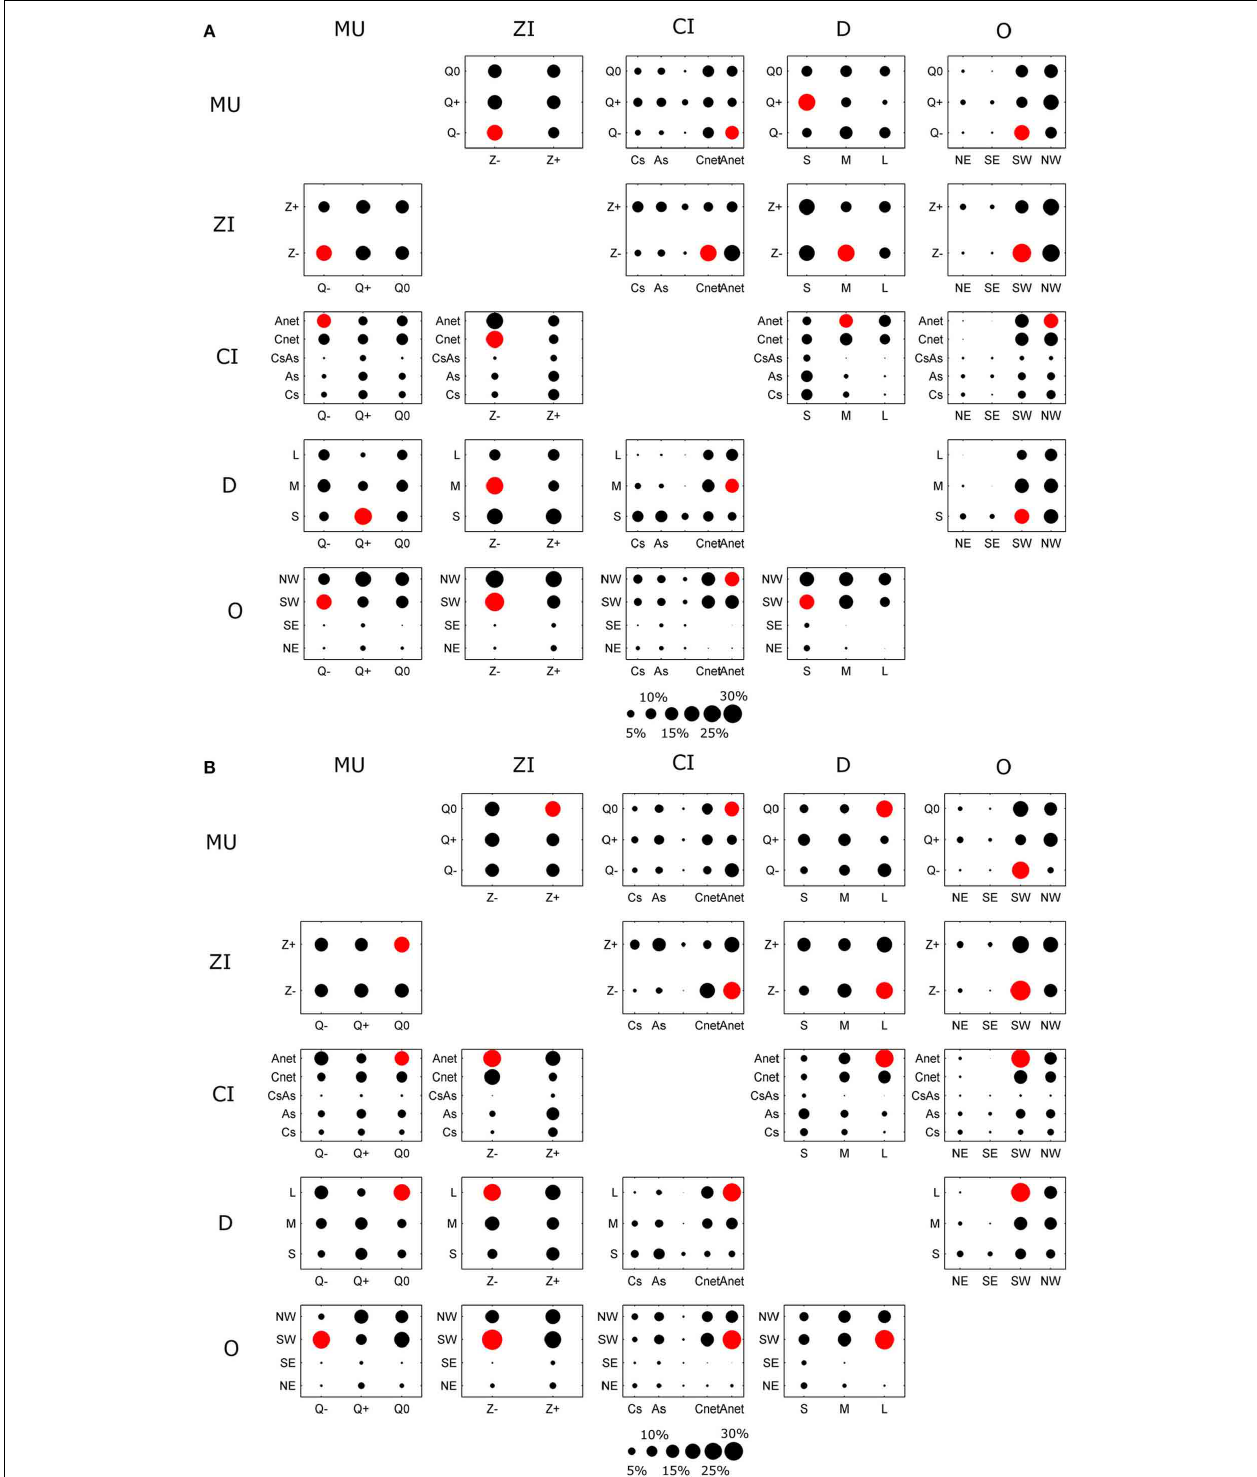
FIGURE 10 | Multi-dimensional catalog frequencies for (A) summer and (B) winter. Each panel correspond the frequency of one characteristics compared with other. For example in the MU vs. ZI panel for summer and